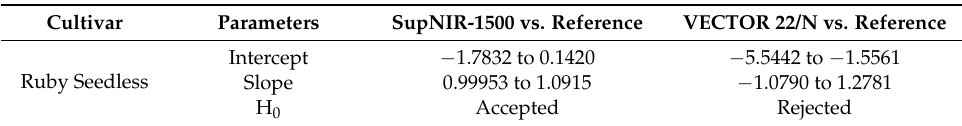
Table 2. Passing-Bablok regression results for least-squares support vector machine of total soluble solid contents prediction at 95% confidence level.